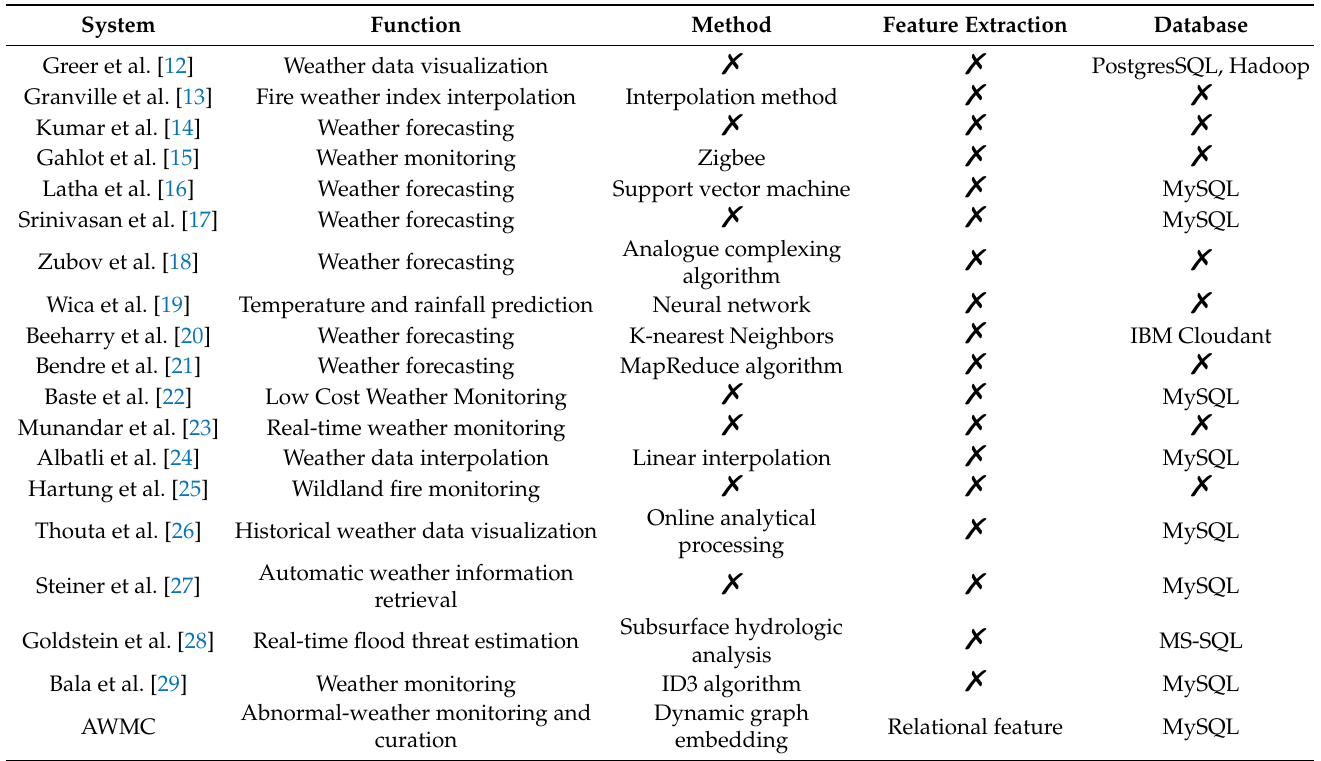
Table 1. Comparison of existing weather systems and AWMC ( (cid:37) : the system does not use the method, feature extraction, or